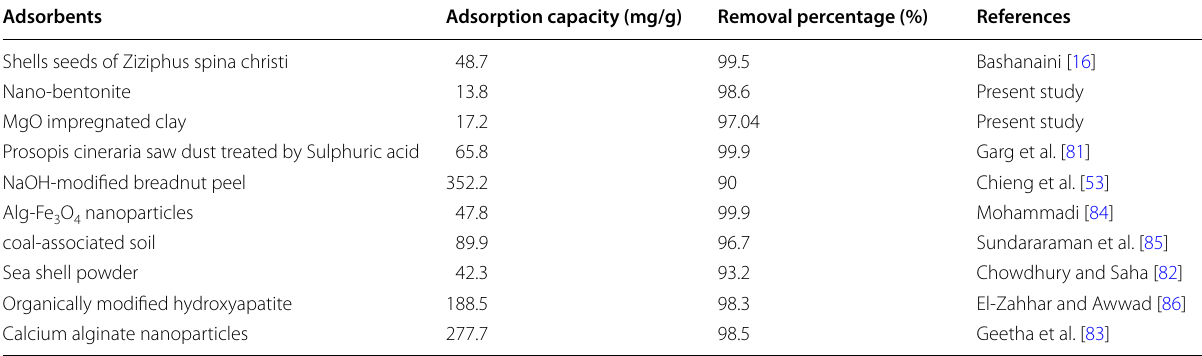
Table 8 Adsorption capacities of different adsorbents previously reported for the removal of MG compared with nano-bentonite and MgO impregnated clay